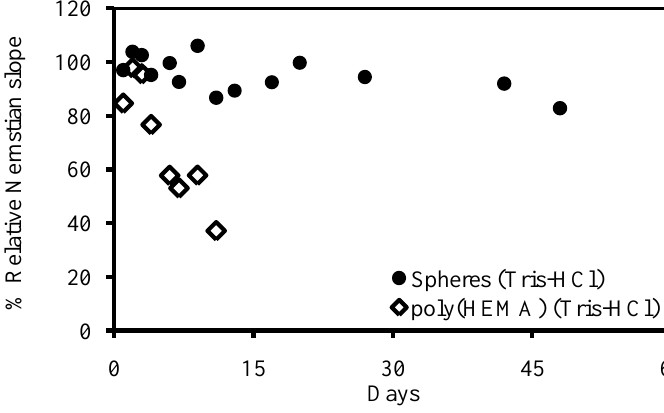
Figure 8. Comparison of the long term stability of biosensors based on AOX-poly(nBA-NAS) microspheres and poly(HEMA) film.